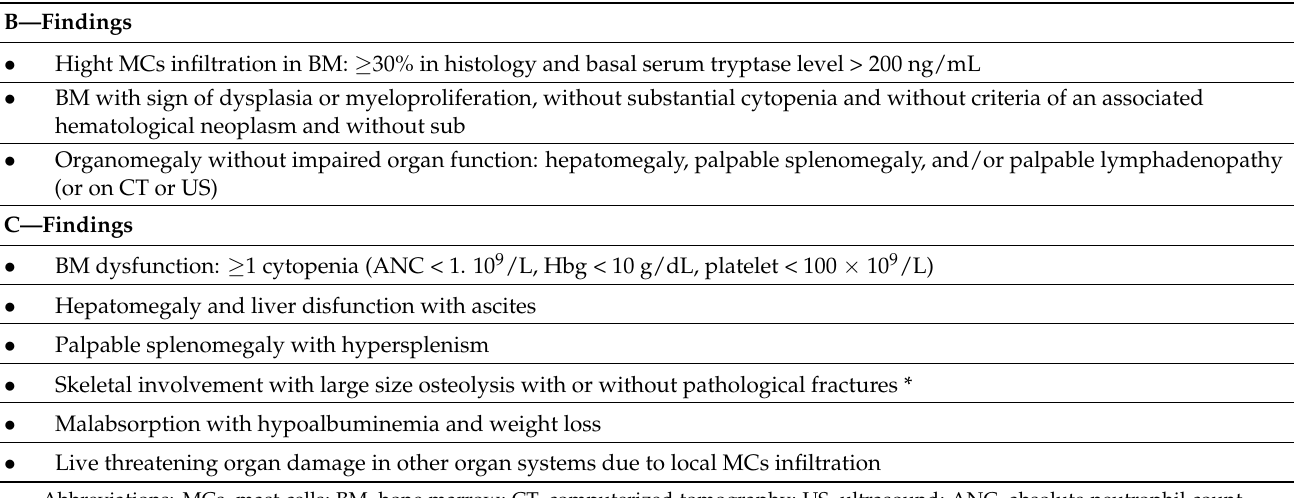
Figure 2. Bone marrow histology of patient affected by SM. Panel ( A ): Giemsa; 40 × : perivascular spindle-shaped mast cells with abnormal cytologic features (spindling and hypogranularity). Panel ( B ): CD117; 40 × : in tissue sections, an immunohistochemical stain can be used for identification of mastcells. Panel ( C ): immunostaining with CD25 shows an atypical immunophenotype of mast cells with membrane reactivity. Table 3. Definition of B and C findings for Systemic Mastocytosis